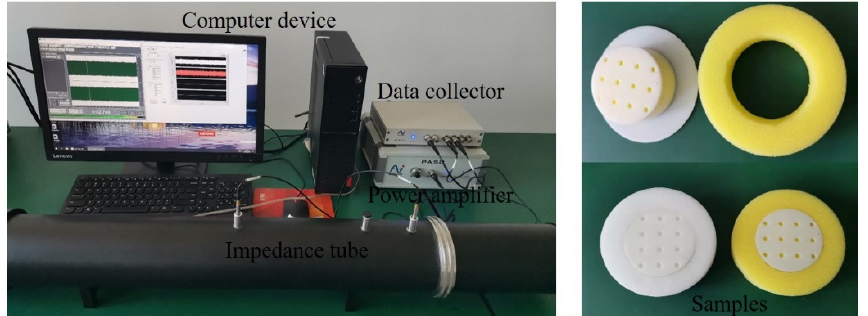
Figure 3. Experimental equipment and samples. Table 1. Parameters of PPCS Samples.